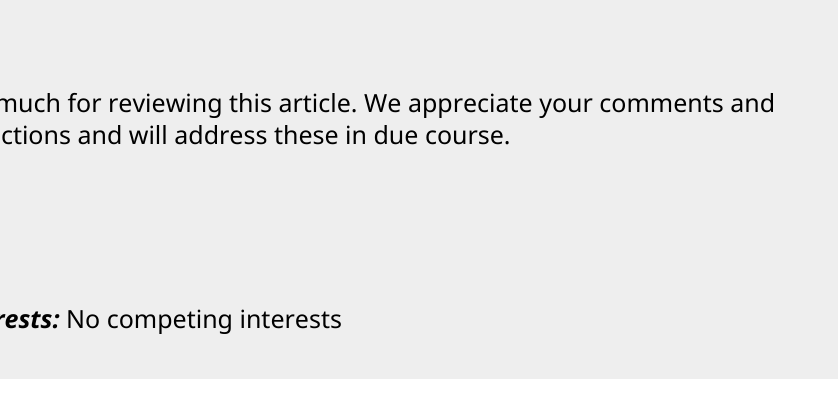
values for MZCRC1 cell proliferation above line for toxicity 50